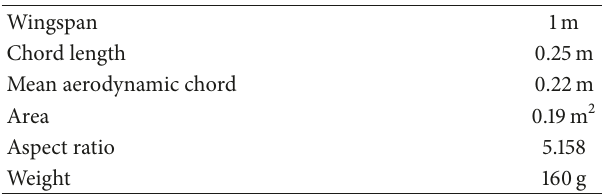
Table 1: Specifications of the